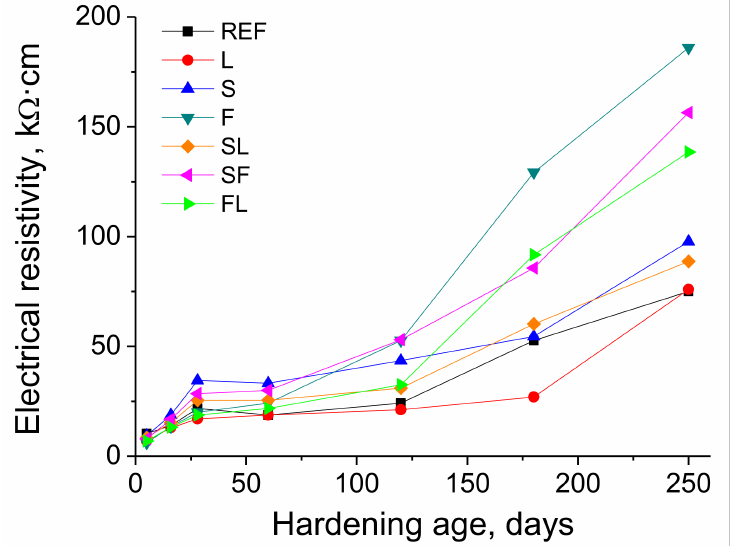
Figure 8. Electrical resistivity results noted for the analyzed